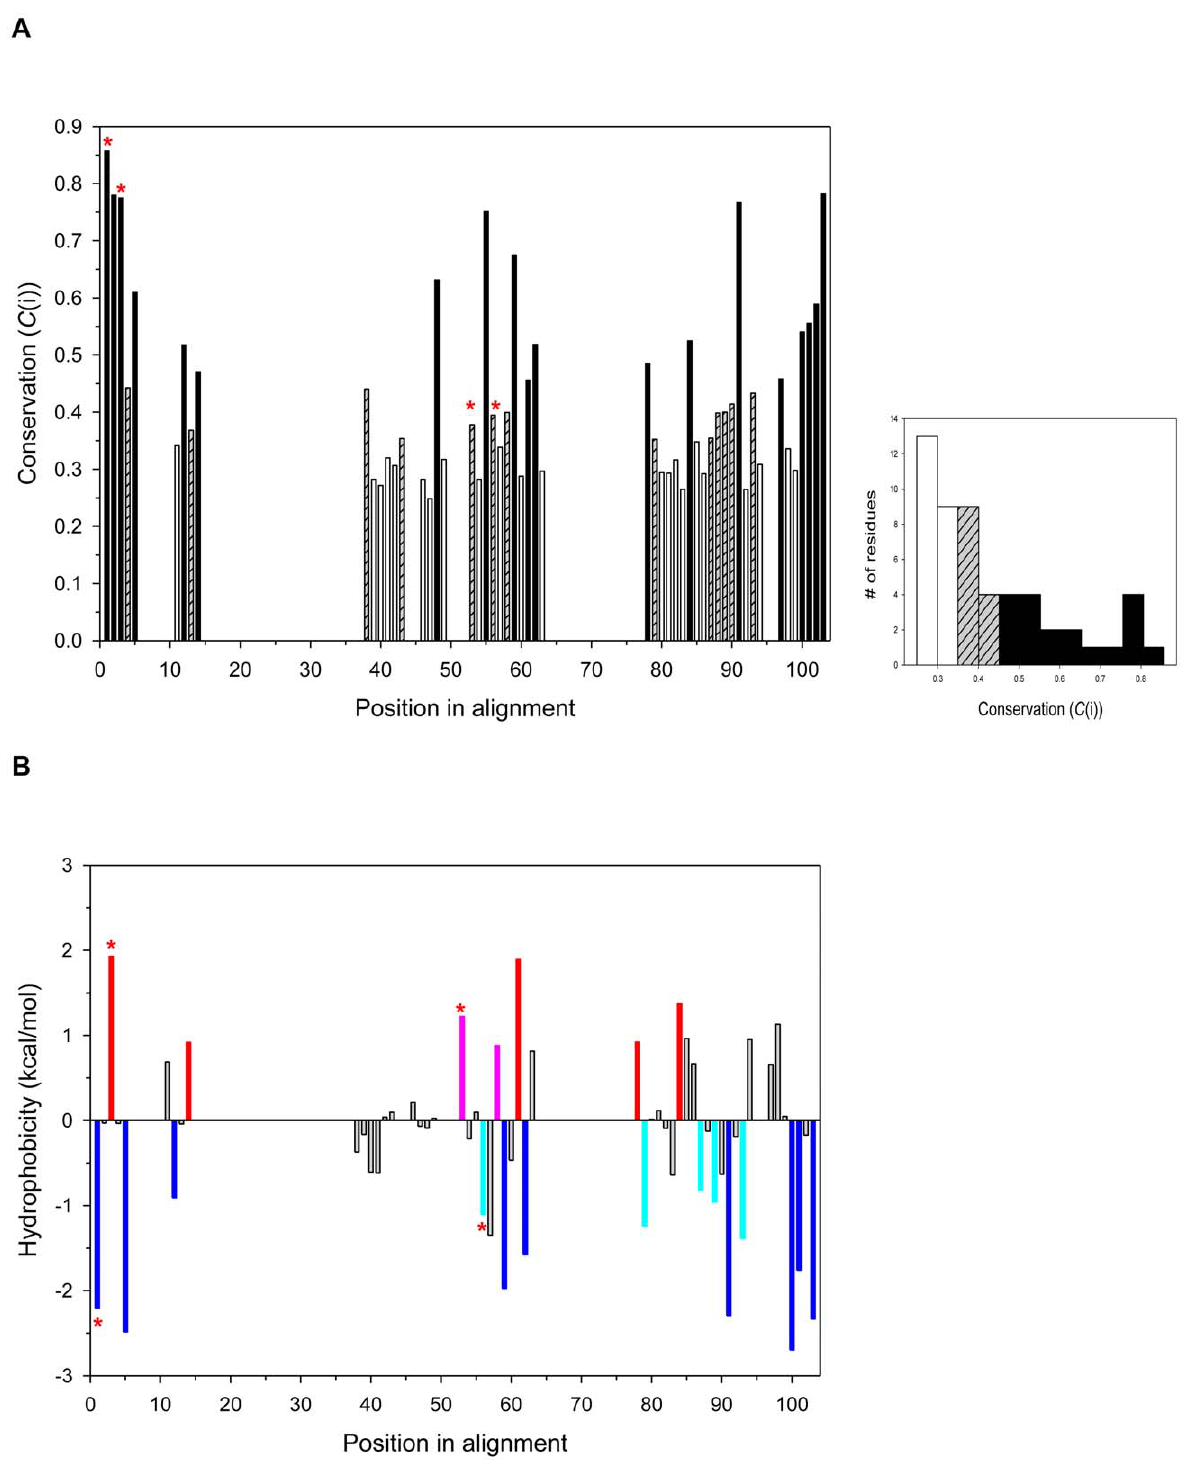
Figure 3. Sequence conservation analysis of the CID. (A) The figure shows the distribution of conservation scores ( C (i)). Positions with high conservation are represented by black bars ( C (i) $ 0.45), positions with moderate conservation by grey hashed bars (0.35 # C (i) , 0.45), and positions with less conservation by white bars ( C (i) , 0.35). The conservation values of the positions with more than one gap in the alignment are calculated as zero. Right insert shows the histogram of conservation in terms of the number of positions. Bars annotated with red stars are the conserved residues which may interact with the substrate. (B) The figure shows the average hydropathy profile analysis in the superfamily. Highly conserved hydrophobic positions are represented by blue bars and moderately conserved positions by light blue bars. Highly conserved hydrophilic positions are represented by red bars and moderately conserved positions by pink bars.